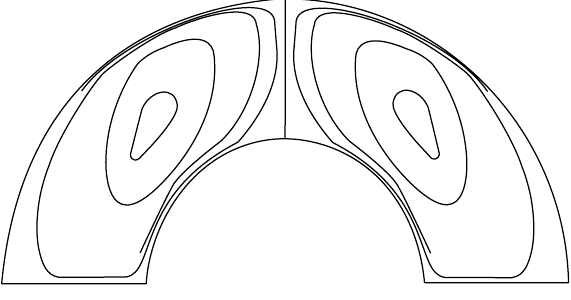
Figure 4.5. Contours of the meridional streamlines. Basic flow for Re =